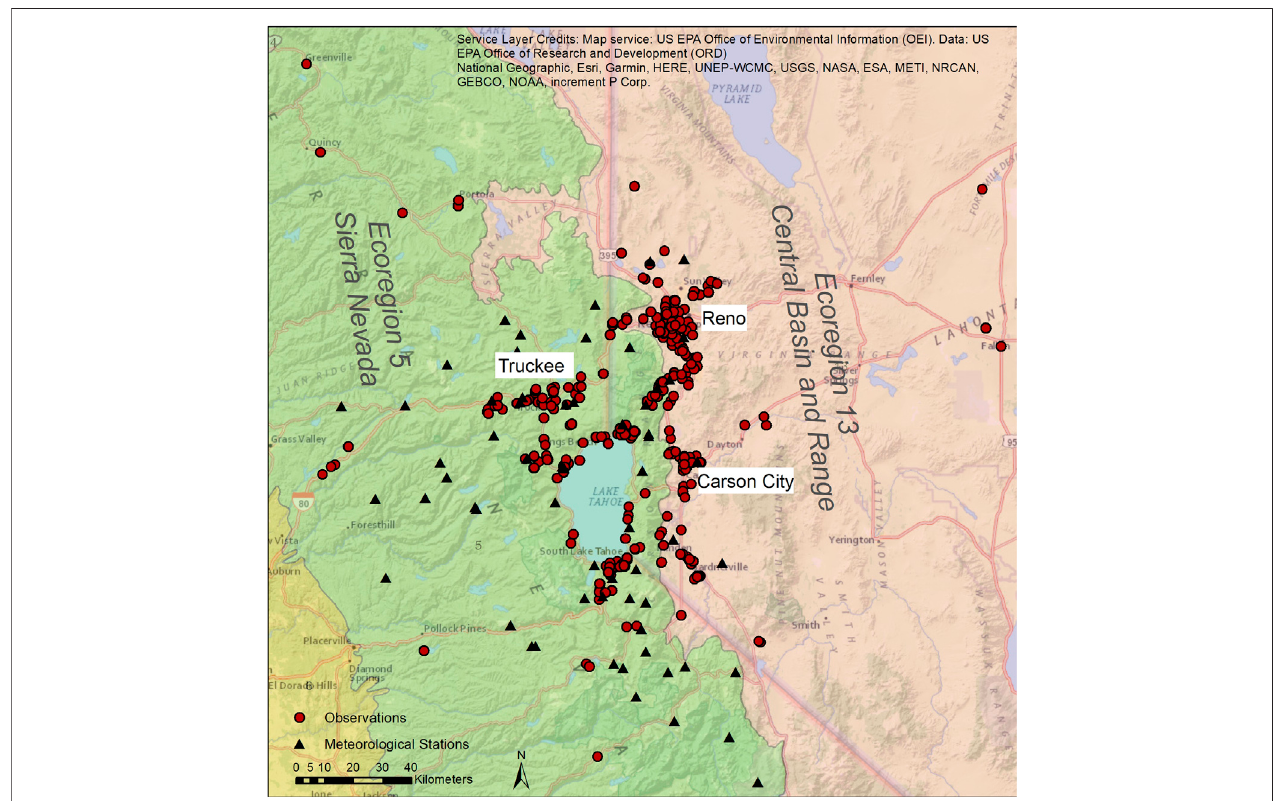
FIGURE 2 | Most of the observations (red circles) were from the communities surrounding Lake Tahoe, the Truckee Meadows (inclusive of the cities of Reno/ Sparks) and Carson City, Nevada. Black triangles represent meteorological stations used in this study. Green background indicates EPA Level III Ecoregion number 5 and the pink background color indicates EPA Level III Ecoregion number